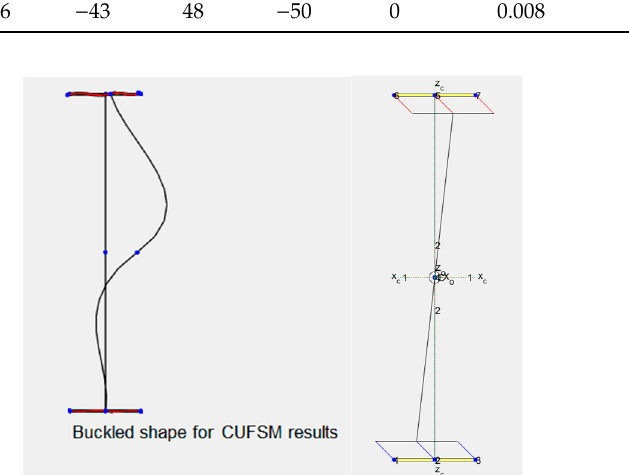
Figure 7. Variation in the minimum cross-sectional area with noncompact web in the first 2000 harmony search iterations .